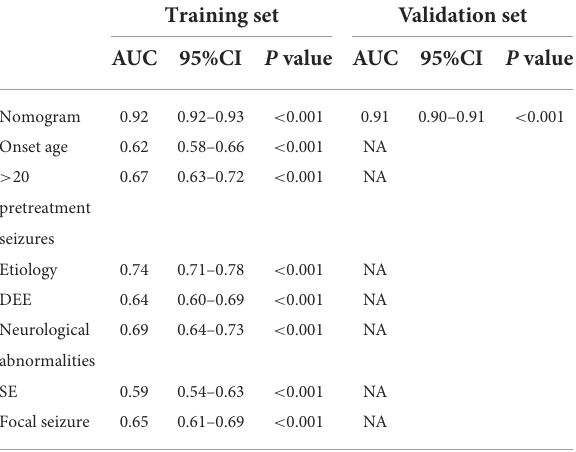
TABLE 4 AUCs of ROC curves for the nomogram and variables from the logistic regression model in the training as well as validation sets. Training